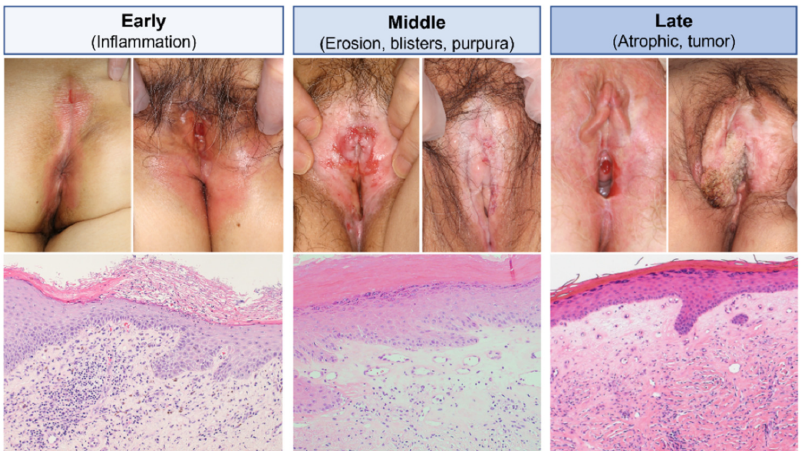
Figure 1. Stage-specific clinical and pathological features of female genital LS. In the early clinical stage of LS ( left columns ), it initiates as erythema and mild erosion, mostly covering the entire peri- vaginal and perianal area. Pathologically, early LS shows parakeratotic scales, irregular epidermal thickening, and intense inflammatory infiltrates in the upper dermis with faint homogenization of dermal collagen bundles. The condition fluctuates and gradually exacerbates into persistent erosions with focal blistering and induration, leading to a whitish-pale appearance in the middle clinical stage ( middle columns ). Note that dermal hyalinosis is more apparent with dilated blood vessels. The chain of these inflammatory events finally results in scarring and irreversible adhesion of external genital parts, and abruptly develops squamous cell carcinoma in the late clinical stage ( right columns ). The preexisting dermal hyalinosis in the skin pathology further extends diffusely, becoming more prone to eosinophilic staining and a thinner color. Dilated blood vessels in the upper dermis look atrophic, narrowing in size with thickening vessel walls.